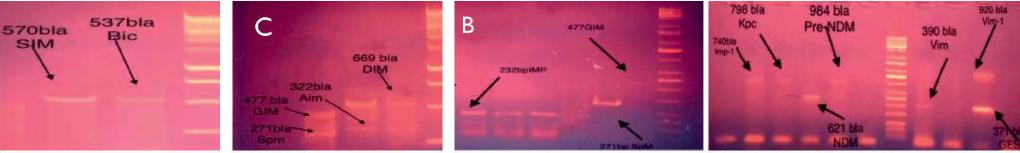
Fig. 5. Agarose gel electrophoresis (1% agarose, 7 v/cm 2) and Ethidium bromide staining to detect A, B, C, D Metallo gene using template DNA prepared by boiling method. Right Lane, molecular size DNA ladder A and B (100 bp DNA Ladder); C and D (250 bp ladder) Left lanes DNAs isolated from A. baumannii sample showed Positive